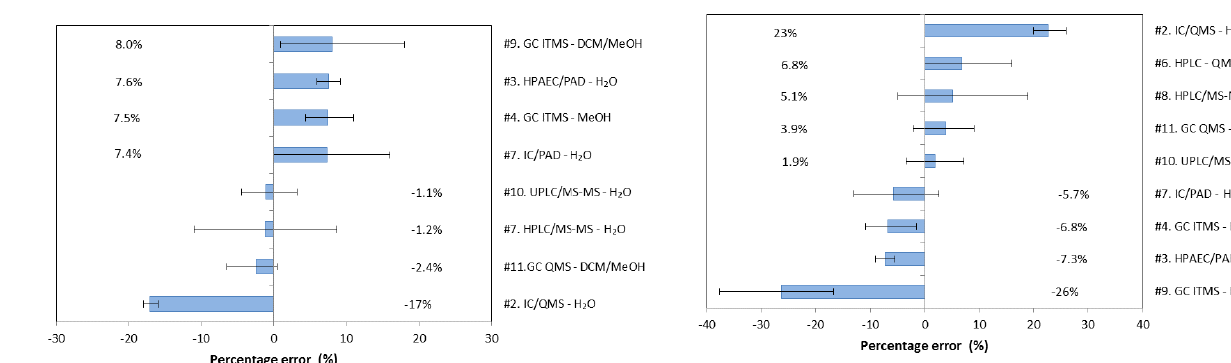
Figure 6: Calculated mean percentage error (PE) for each of the eight laboratories for which the mannosan to MA ratio could be derived. The PE was calculated according to eq. 1 (Section 2.5) for each of the six sectors received by the participating laboratories. The mean PE for each laboratory accounts for the PE calculated for all of the six sectors. The laboratory number, ranging from 1-13, the analytical method and solvent used for extraction are mentioned at the right of the figure.